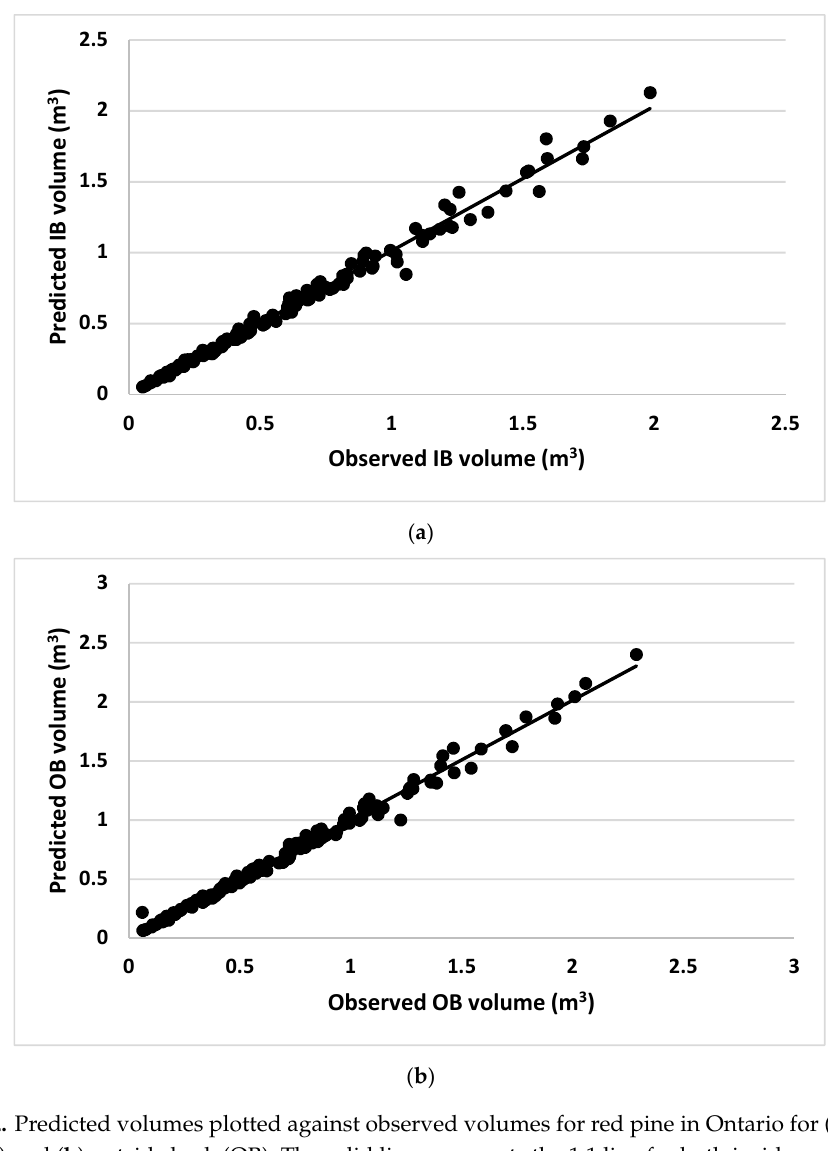
Figure 2. Predicted volumes plotted against observed volumes for red pine in Ontario for ( a ) inside bark (IB) and ( b ) outside bark (OB). The solid line represents the 1:1 line for both inside and outside bark volumes.